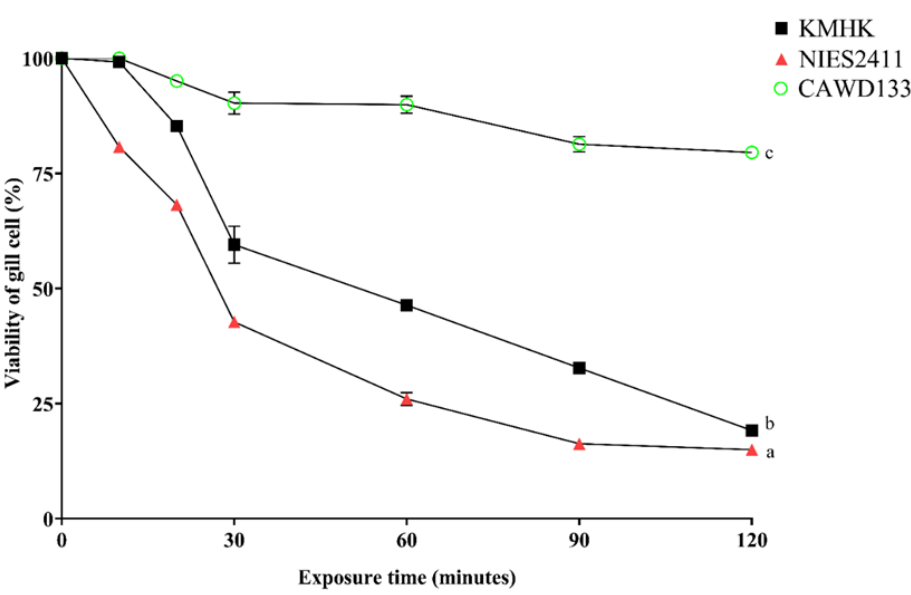
Figure 3. Ichthyotoxicity of three K. mikimotoi strains at log phase (initial algal density of 4 × 10 4 cells mL − 1 ) at 30 ppt salinity. Viability of gill cells (%) = (reading of sample—reading of blank cell) * 100/(reading of solvent control—reading of blank cell). The initial algal cell density of K. mikimotoi was 4 × 10 4 cells mL − 1 . Non-toxic algal species Dunaliella tertiolecta (STK-2) was used as control and no mortality of the gill cells was observed within the 120 min exposure. Each data point